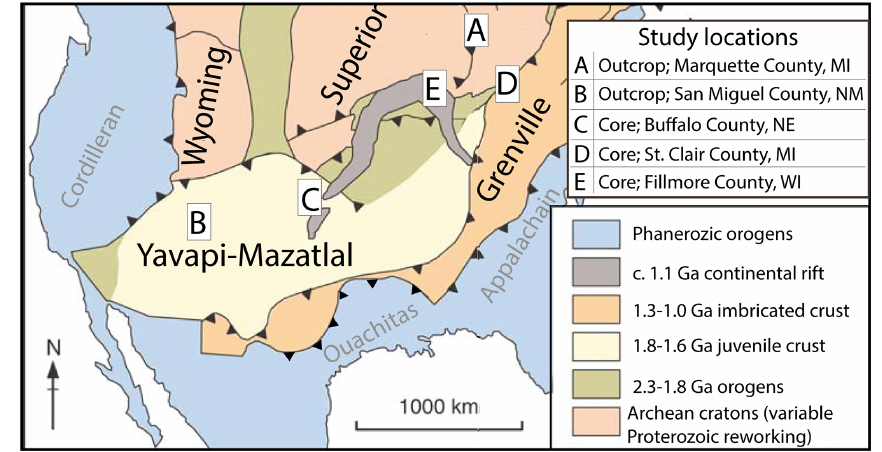
Figure 1. Precambrian tectonic elements map with the location of the nonconformity analog study sites (after St. Onge et al., 2009). (a) Lake Superior, Presque Isle, Michigan outcrop, (b) Gallinas Canyon, New Mexico outcrop, (c) R.C. Taylor 1 core, (d) CPC BD-139 core, and (e) BO-1 core.